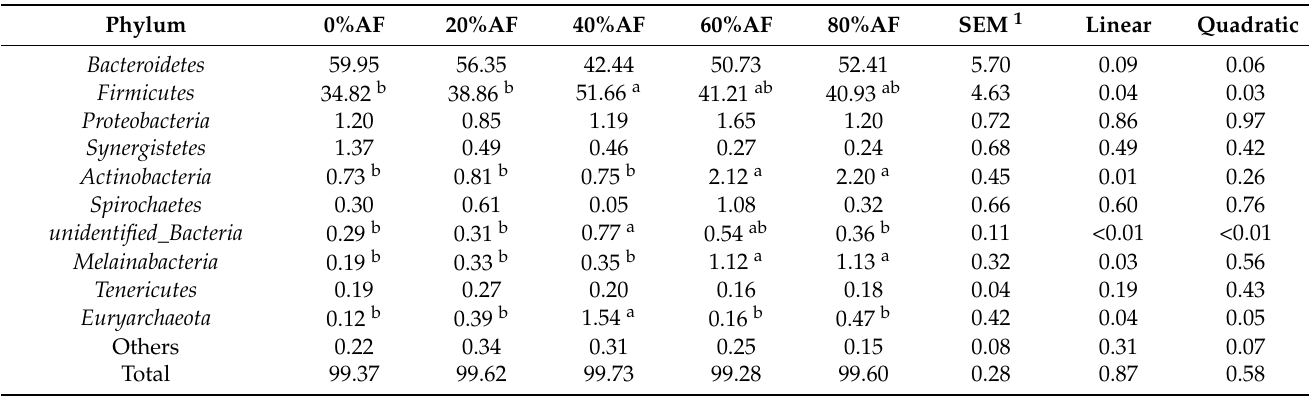
Table 5. Composition and relative abundance of rumen bacterial communities at phylum.